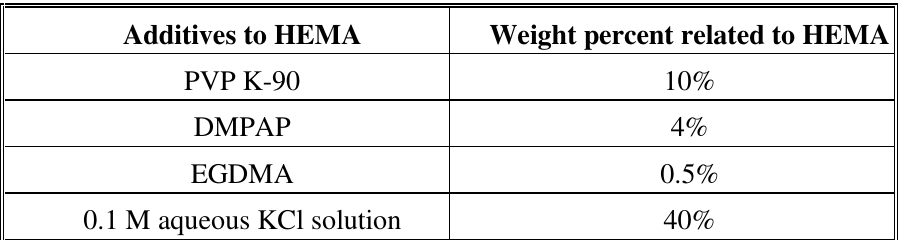
Table 2. Composition (B) of mixture for polyHEMA coatings with PVP K-90 as a filler, expressed in weight percent related to HEMA. Additives to